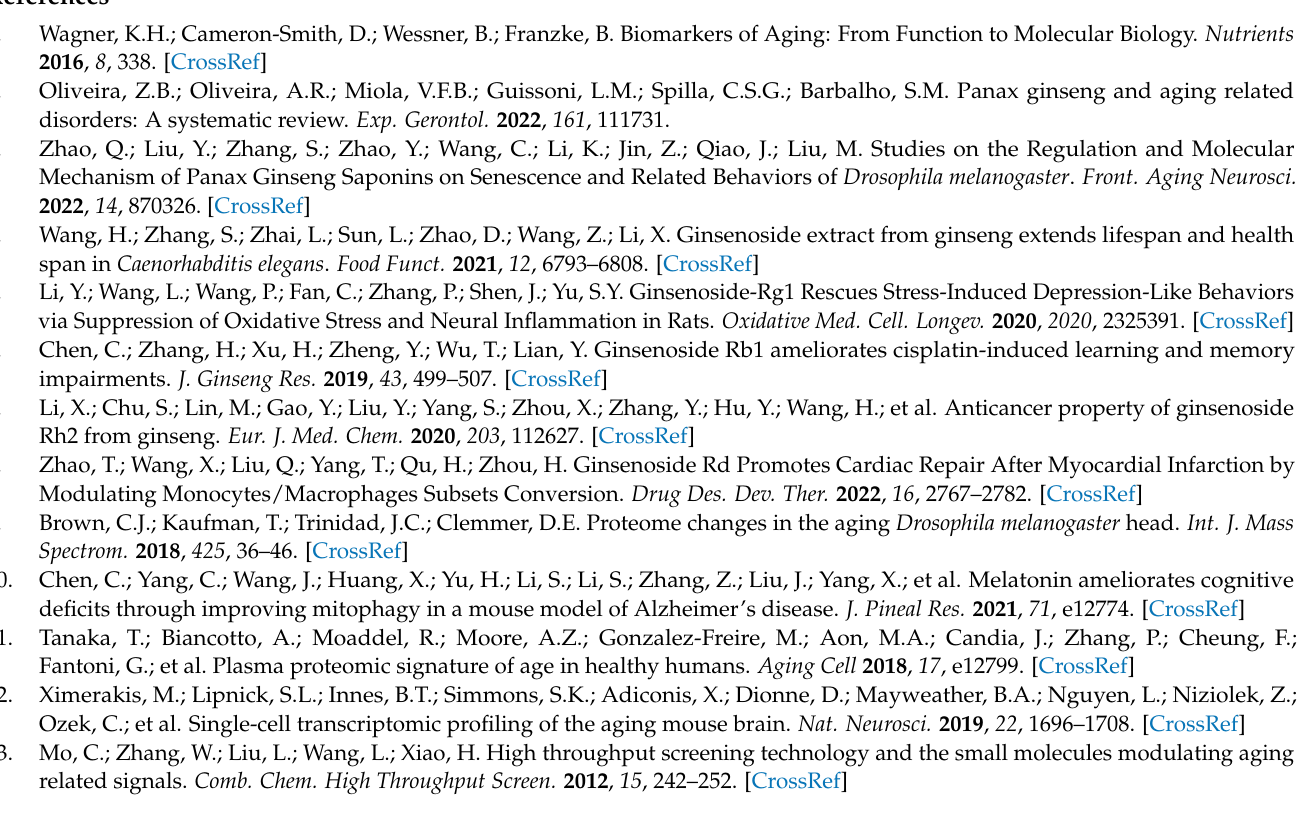
Figure S2: CLS curve of yeast cells with Rg1 treatment at 100–250 µ g/mL; Figure S3: RT–qPCR analysis of expression of glycolysis genes in yeast cells; Figure S4: Expression levels of triose- phosphate isomerase and PGK in KEGG enrichment pathway analysis; Figure S5: Overexpression of CDC19 and deletion of SDH2 counteracted the protective effect of Rg1 against oxidative stress; Figure S6: Spot representation of yeast cells without or with Rg1 (180 µ g/mL) treatment; Figure S7: Speckle phenotype analysis under oxidative (a), high-temperature (b), high-salt (c), and acid stress (d) with or without Rg1 (180 µ g/mL) treatment; Table S1: Average survival rate of ginsenoside monomers Rb1, Rb2, Rg1, Rg2, Rg3, Rd, Rh1, and Rh2 (all at 180 µ g/mL) in extending the CLS of yeast cells; Table S2: List of all proteins displayed in the protein interaction